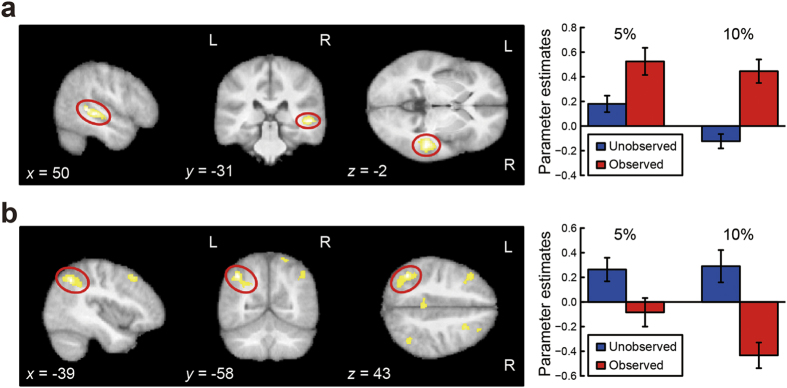
fMRI results of categorical analyses.(a) Right posterior superior temporal sulcus (pSTS) showed activation in the observed condition (Conjunction observed >unobserved in both 10% and 5% MVC tasks). (b) Left inferior parietal cortex (IPC) showed deactivation in the observed condition (Conjunction observed <unobserved in both 10% and 5% MVC tasks). The bar graphs show parameter estimates extracted from a 4-mm radius sphere placed around the group peak within the circled regions for each condition. Data are represented as mean ± SEM. Clusters are illustrated at p < 0.001.